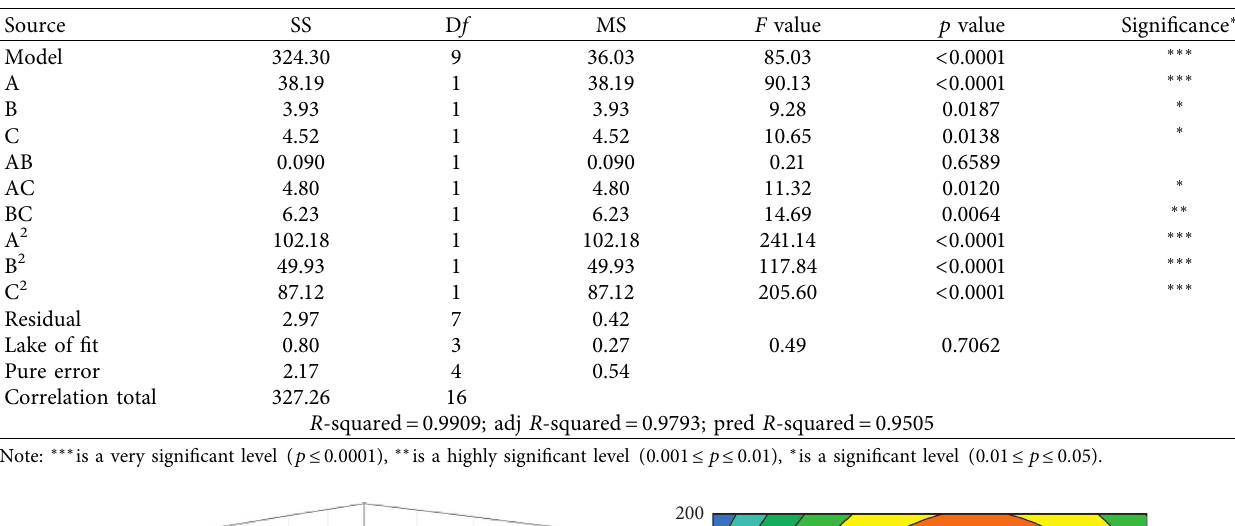
Table 5: Variables and levels used in RSM design.